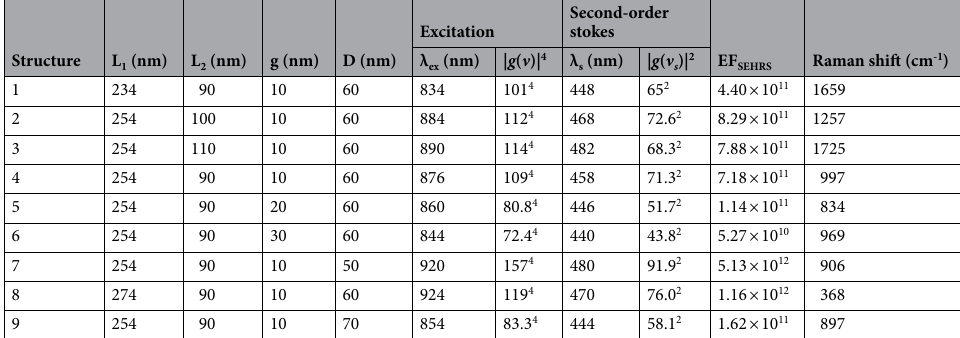
Table 1. Evaluation of the SEHRS EF with the different configuration parameters. Here, the g(v) and g(v s ) are the enhancements of the localized electric fields (|E/E 0 |) at the excitation and second-order Stokes wavelengths, respectively. The monitored position of the electric field enhancements is located in the central gap region of the nanorice trimer in the x–y plane. The SEHRS EF is calculated by formula